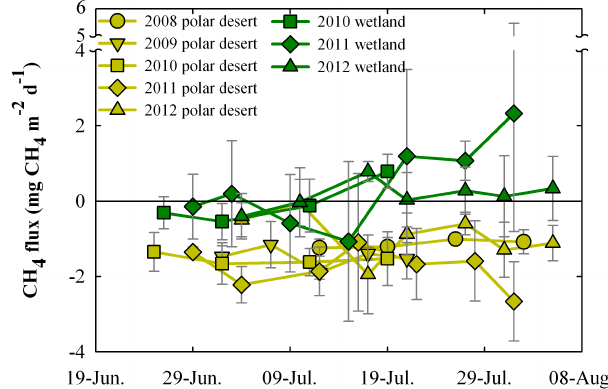
; ± 1SD) from four polar desert 4